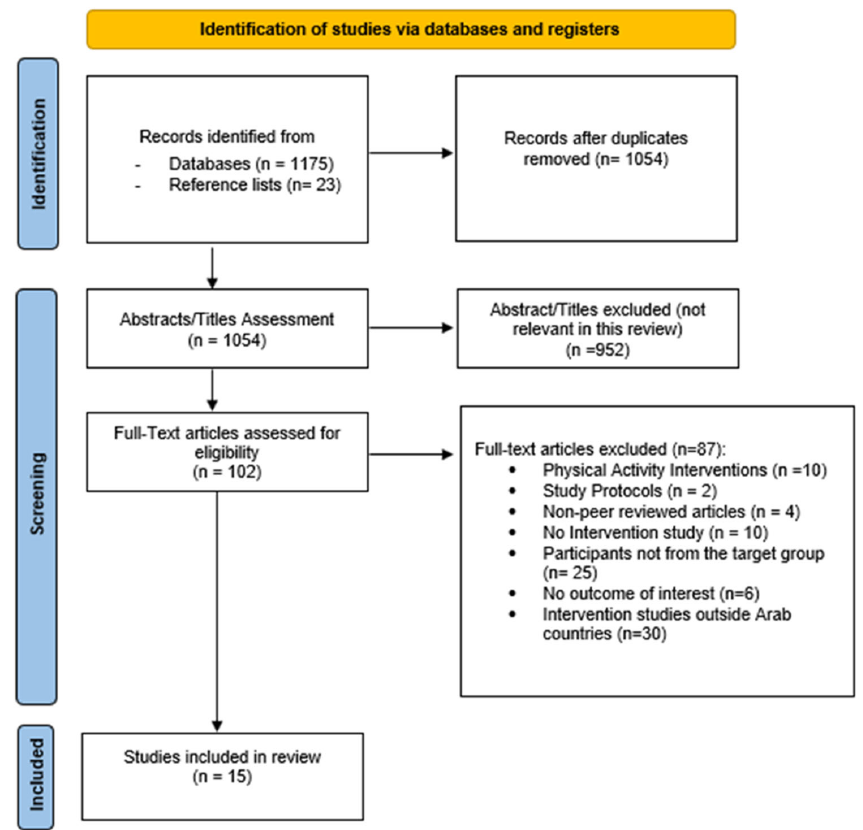
Figure 1. Flow chart of included and excluded studies.